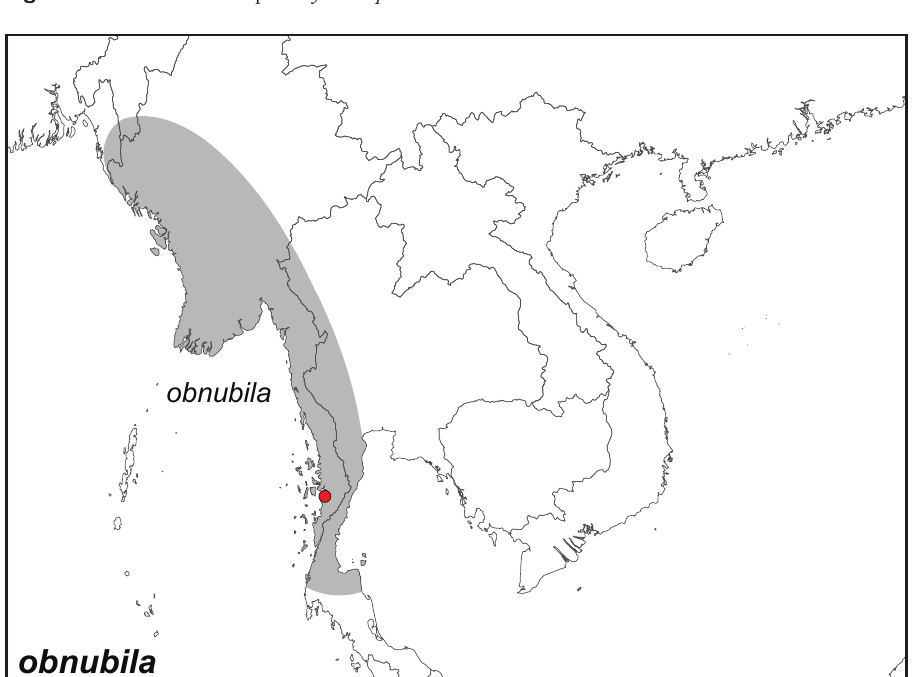
Figure 48. Distribution map of Elymnias obnubila